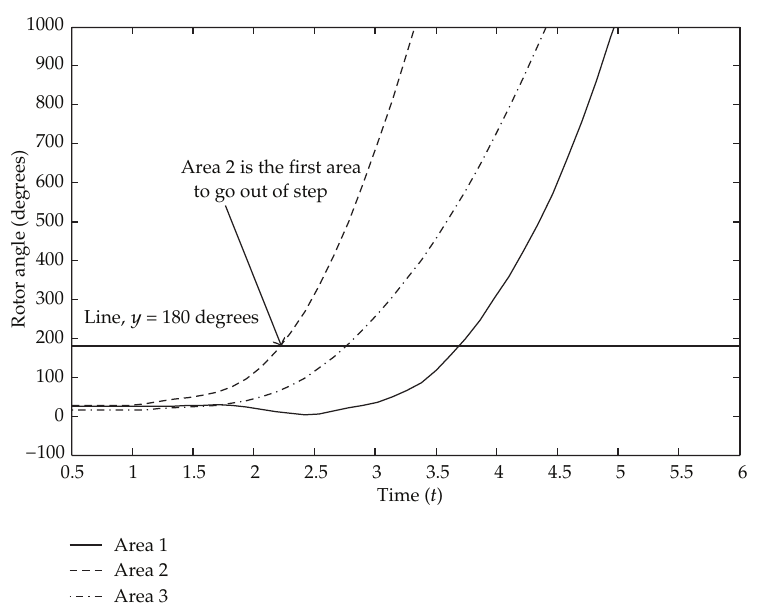
Figure 6: The Area 2 COI-referred rotor angle goes out of step the